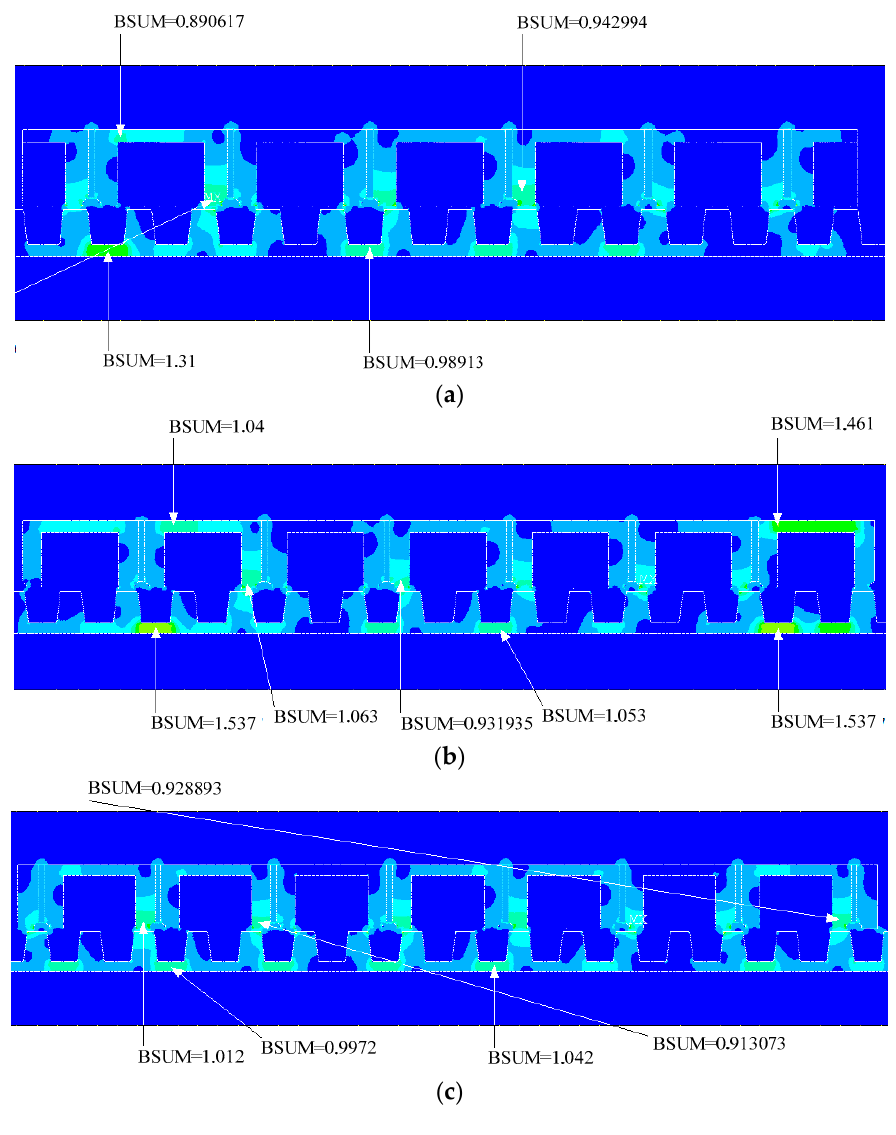
Figure 7. Definition of key parameters.